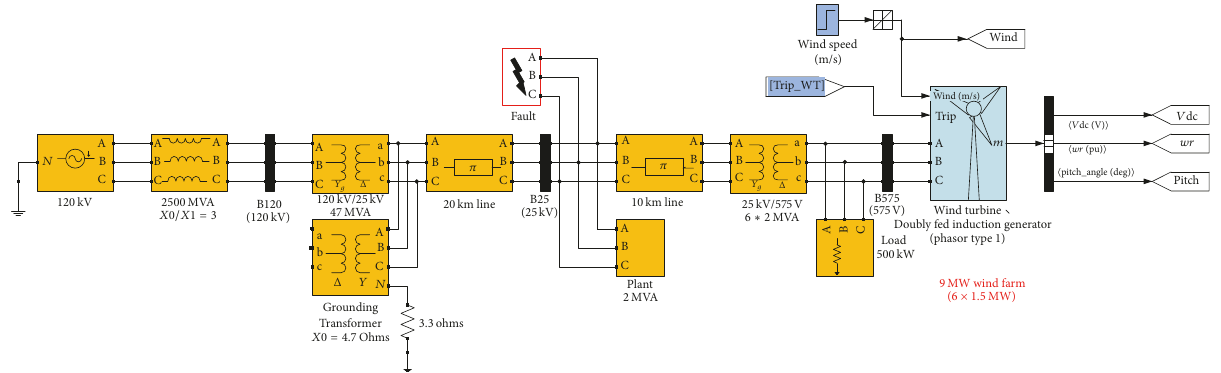
Figure 14: MATLAB/Simulink model of a 9MW DFIG WECS wind farm